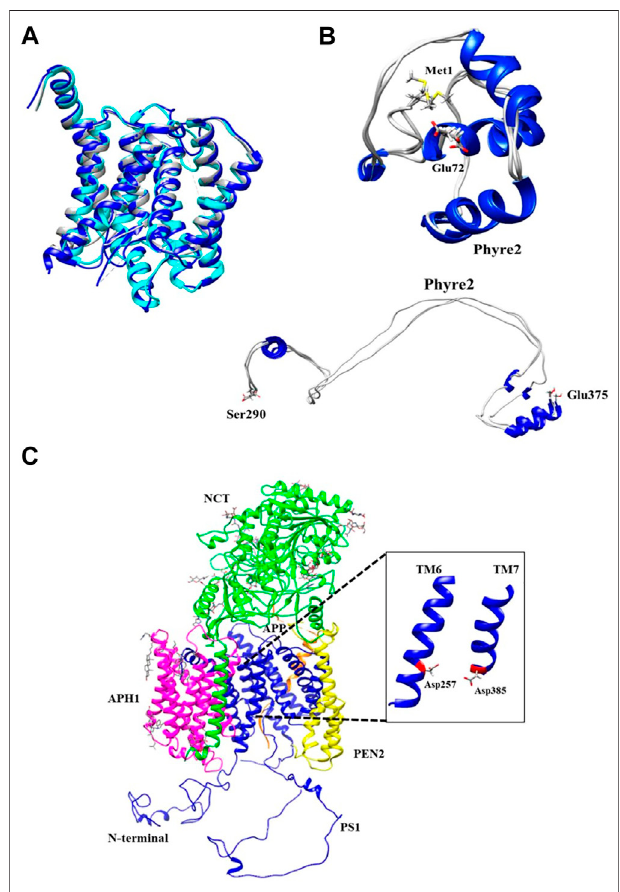
FIGURE 2 | Phyre2 modeling for PS1 structure in the γ -secretase complex. (A) Structural alignment of cryo-electron microscopic structure PS1 protein domains as found in PDB ID: 6IYC (Blue), 5FN2 (Cyan), and 5A63 (Gray). (B) Re fi ned and unre fi ned modeling of PS1 N-terminal fragment Met1-Glu72 and Ser290-Glu375, using Phyre2. (C) Modeling of the active γ -secretase heteromer. Inset shows PS1 transmembrane domains forming the pocket including TM6 and TM7 together with the active sites Asp257 and